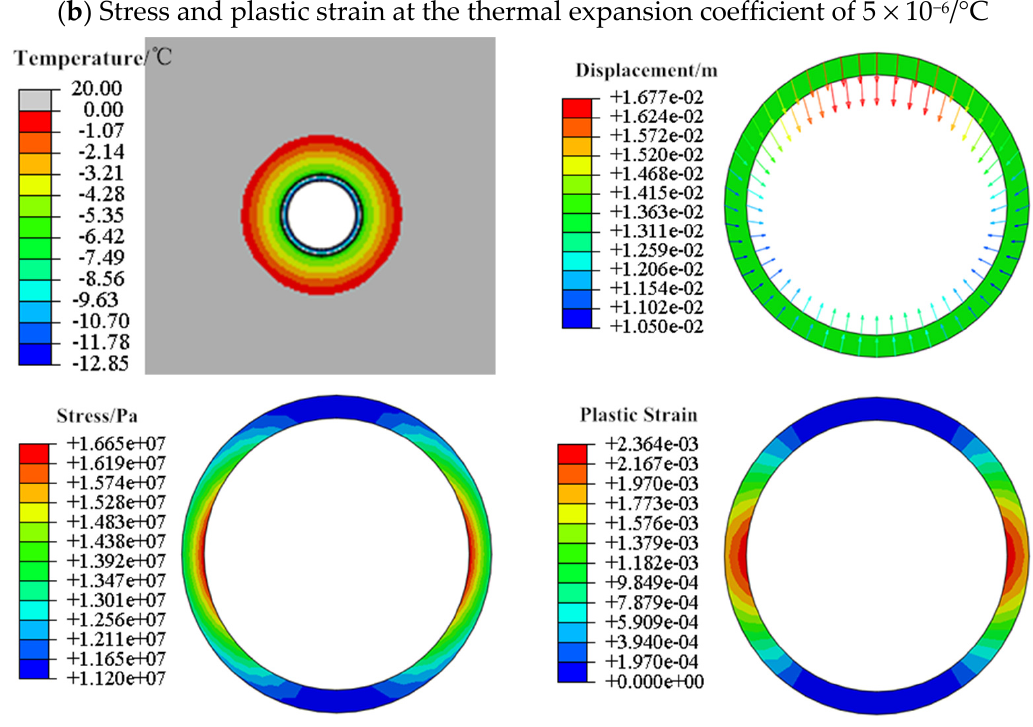
MPa, respectively. This is because the increase of the thermal expansion coefficient leads to an increase in the expansion value of water freezing, and the frost heave force in all